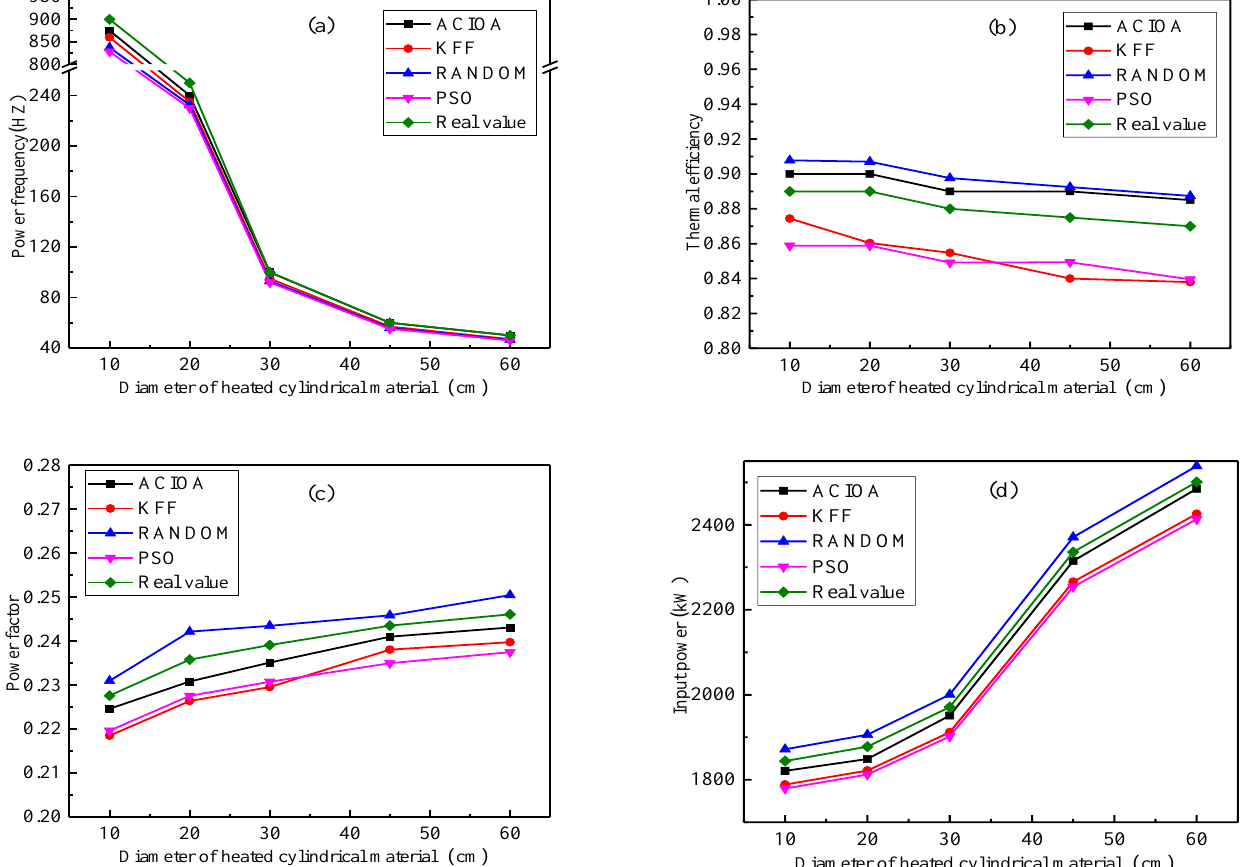
Figure 5. Effect of diameter on circuit performance parameters. ( a ) power frequency; ( b ) thermal efficiency; ( c ) power factor; ( d ) input power.